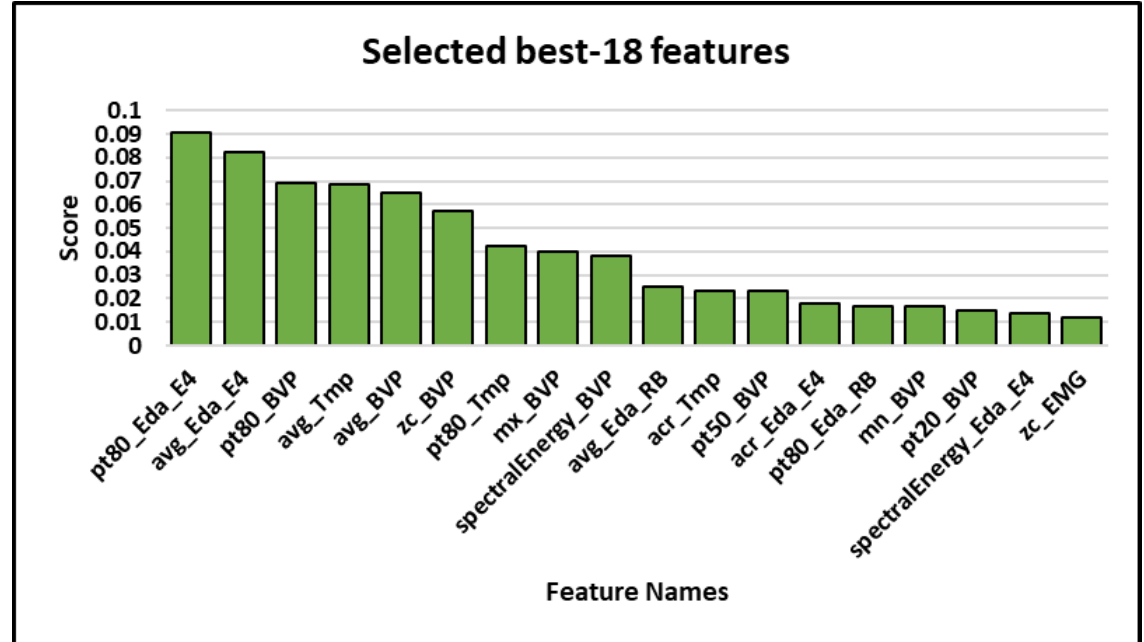
Figure 7. The overall 18 best features. Note: pt80: 80th percentile; avg: average; zc: zero crossings; mx: maximum; acr: auto-correlation; pt50: 50th percentile; mn: minimum; pt20: 20th percentile; BVP: Blood Volume Pulse; HR: Heart Rate; Tmp: Temperature; Eda: Electrodermal activity; RB: Respiration belt; E4: Empatica